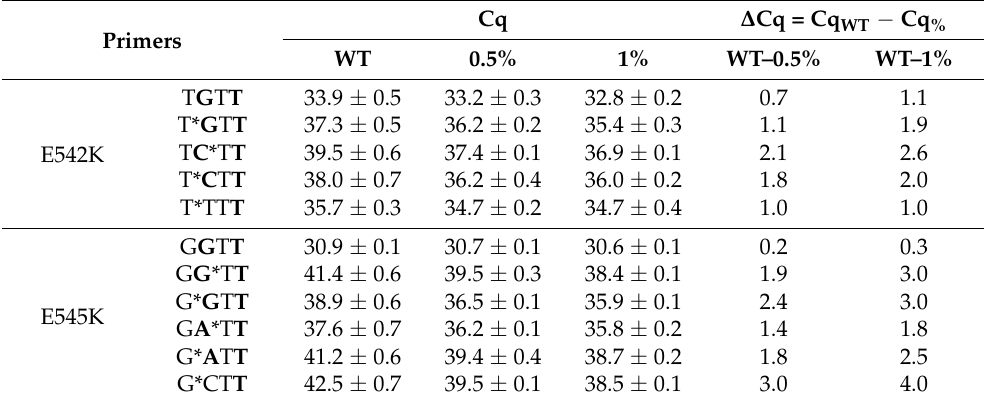
Table 4. PIK3CA mutations detection by AS-PCR using various mutation percentages (total 10 4 copies per